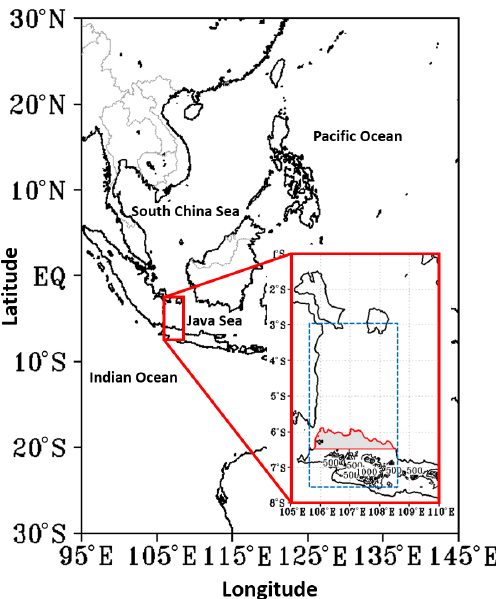
Figure 1. A map showing the Maritime Continent and its surround- ing area. The main area of interest in this study is depicted as the in- set, with coastlines and topographic contours. The red-line bordered polygon (with land masks over the northern coastal plain of West Java) defines the area for spatial averaging of gridded precipitation data. The blue-dashed rectangle defines the area for longitudinally (105.5–108.5 ◦ E) averaged precipitation in Hovmöller analysis of Fig.